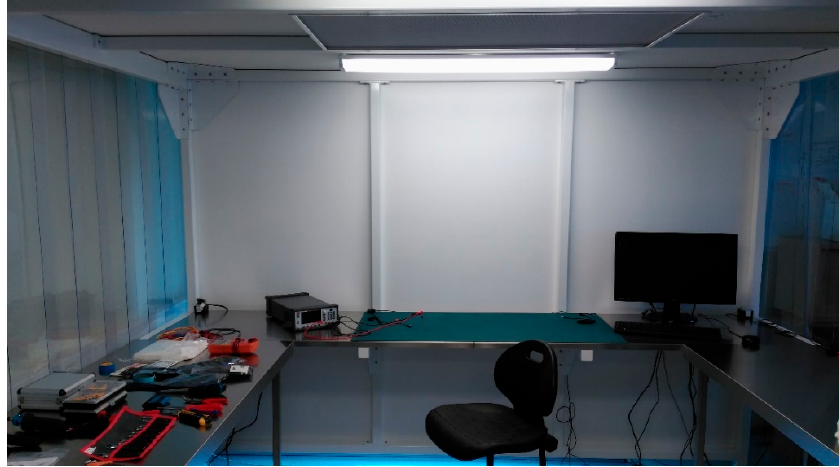
Figure 3. An overview of LTU’s cleanroom used for the development of SE01.